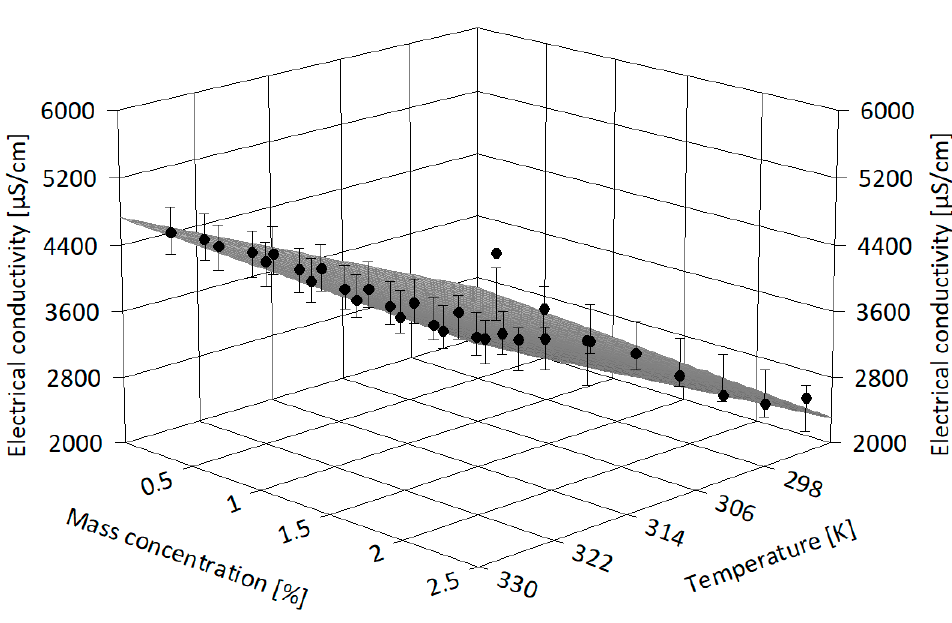
Figure 7. Three-dimensional analysis of alumina suspensions.